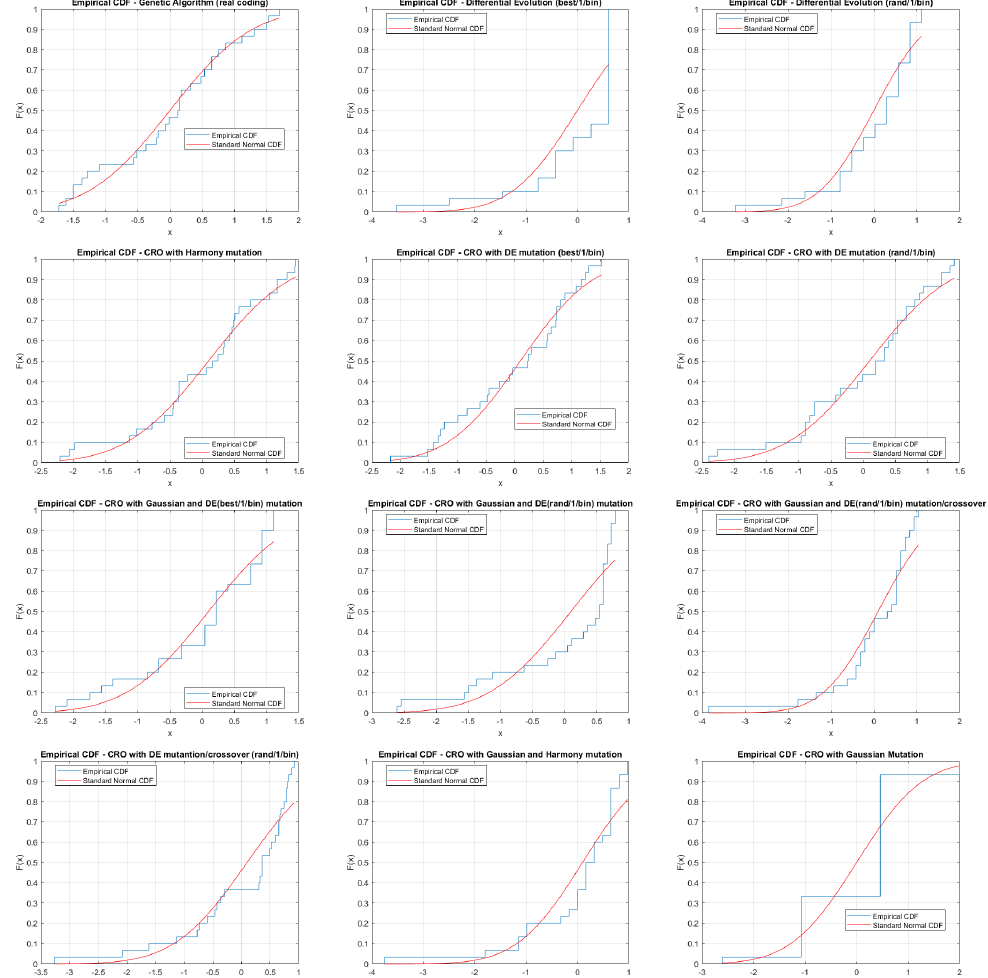
Figure 19. Empirical CDF of the meta-heuristics considered. Results obtained from 30 runs of each